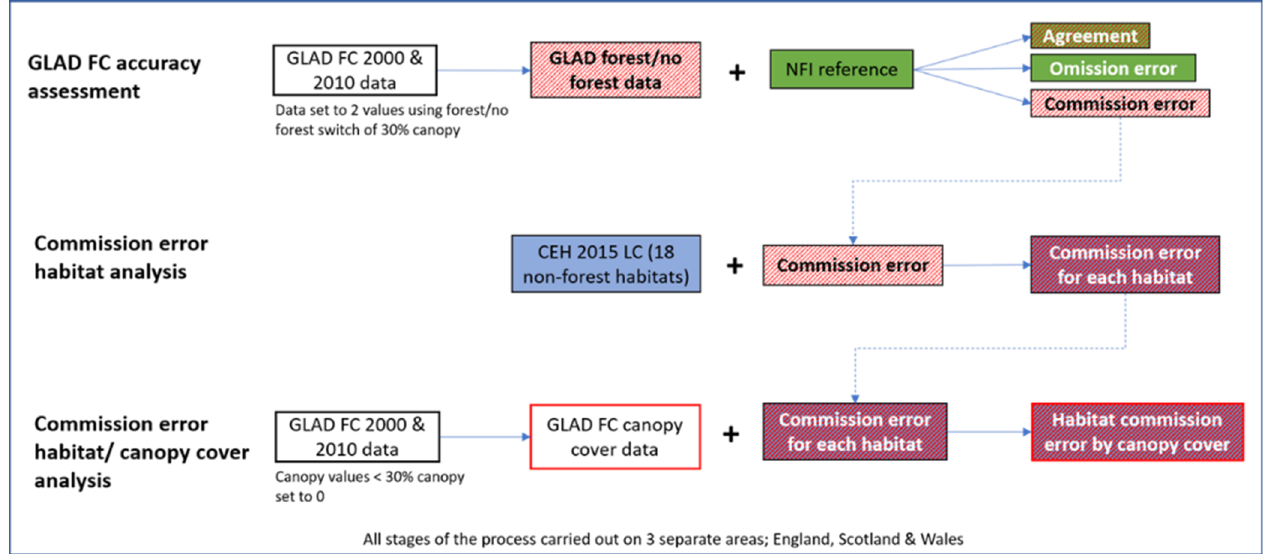
Figure 1. Flow chart showing steps involved in the creation of the accuracy assessments and commission analysis.